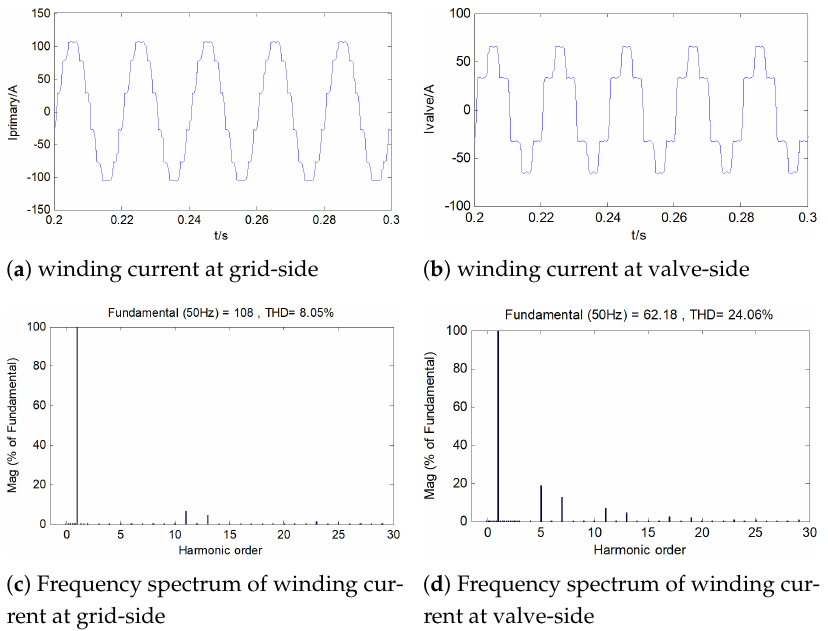
Figure 10. Waveform and frequency spectrum of winding current from the valve-side and grid-side on the right column of the converter transformer under working condition 2.